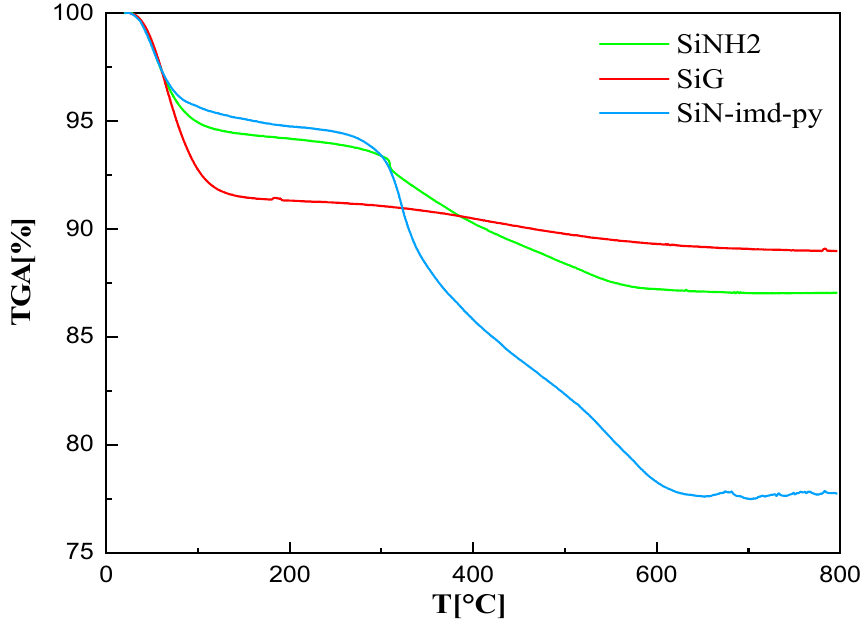
Figure 3. Thermogravimetric curves of free silica SiG , SiNH2 and SiN-imd-py . Figure 3 . Thermogravimetric curves of free silica SiG , SiNH2 and SiN-imd-py .